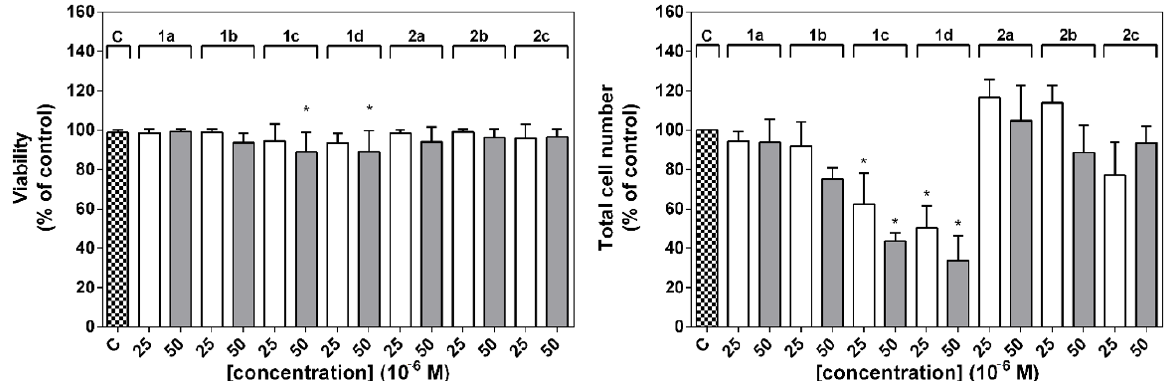
Figure 5. Effect of tacrine-coumarin hybrid compounds 1a – 2c on viability and total cell numbers in A549 cancer cell lines. The viability and total cell number were evaluated 24 h after the addition of the derivatives and are expressed as a percentage of the viable, eosin negative cells or as a percentage of the untreated control of the total cell number, respectively. The results are presented as the mean values ± SD of three independent experiments; statistical significance (*): p < 0.05 for each experimental group is compared to the untreated control.